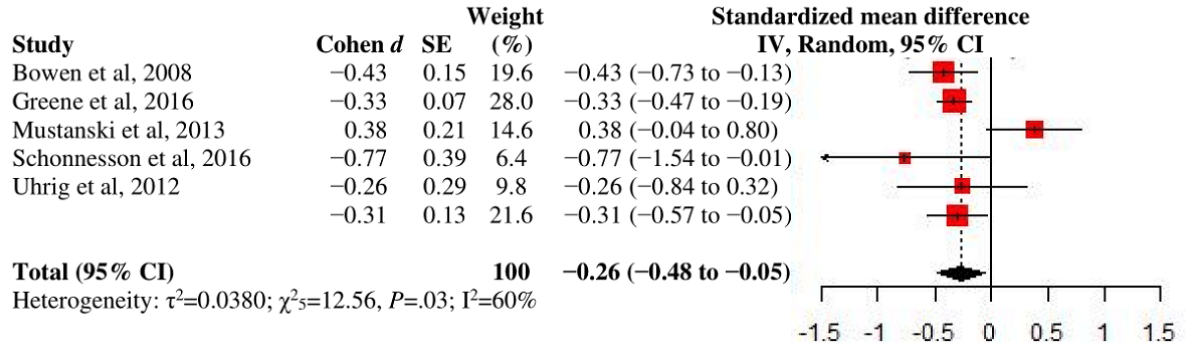
Figure 5. A forest plot of intervention effects on multiple sex